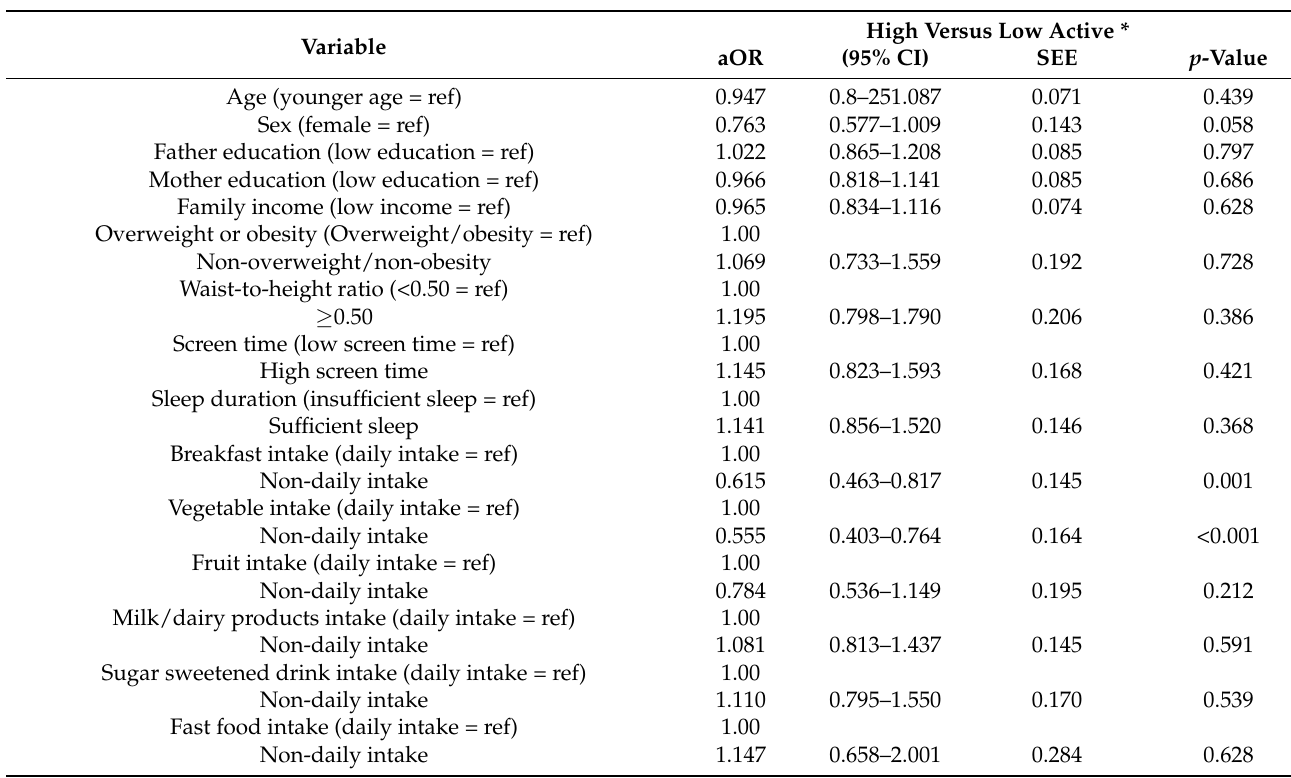
Table 6. Results of logistic regression analysis of selected lifestyle behaviors and overweight/obesity status relative to activity energy expenditure (METs-min/week) among Saudi children, while adjusted for age, sex, and socio-demographic